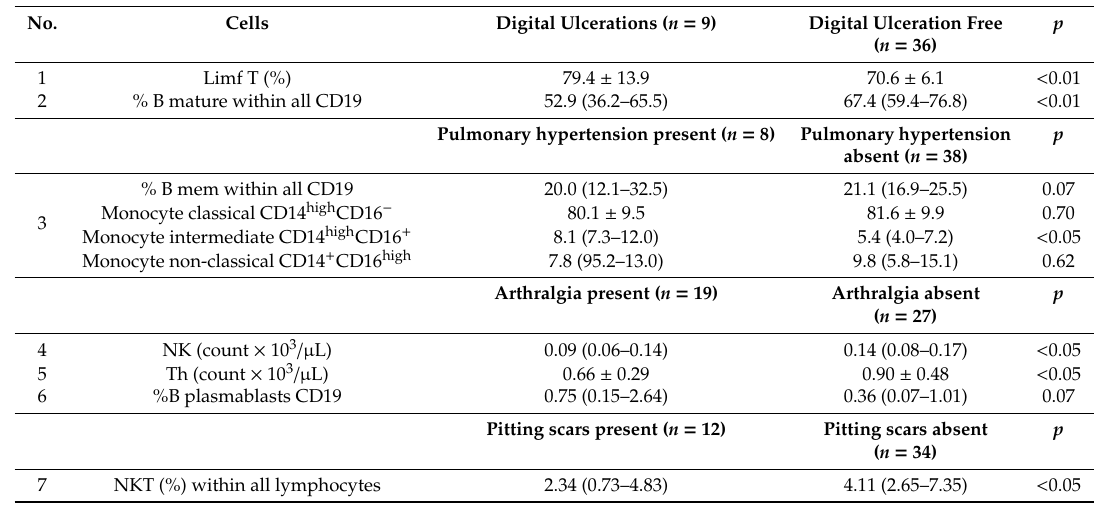
Table 3. Changes in count / frequencies of immunocompetent cells in relation to organ involvement in patients with systemic sclerosis.